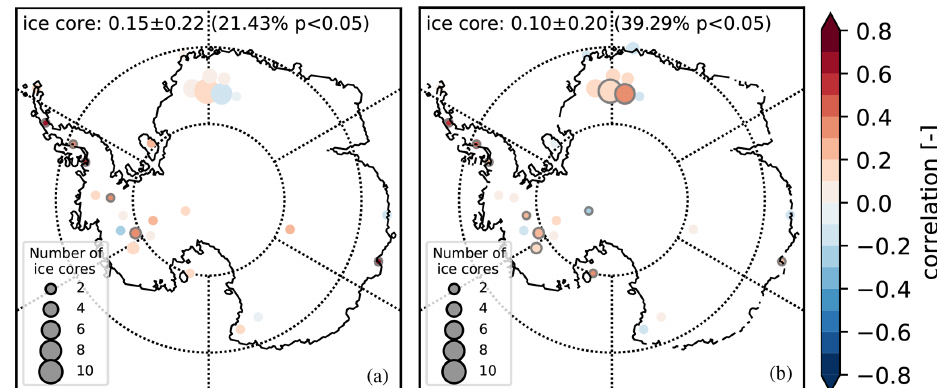
Figure 9. Aggregated ice core annual correlations on a 216km × 216km grid for (a) SMB–SAT annually over 1958–2010 and (b) SMB– δ 18 O 5 yearly over 1871–2010. Grey encircled dots indicate that the correlation value is significant ( p < 0 . 05). The size of the dot represents the number of ice cores aggregated, with the legend given in each panel. The average annual correlation, standard deviation, and percentage of ice cores with p < 0 . 05 are provided in each panel.